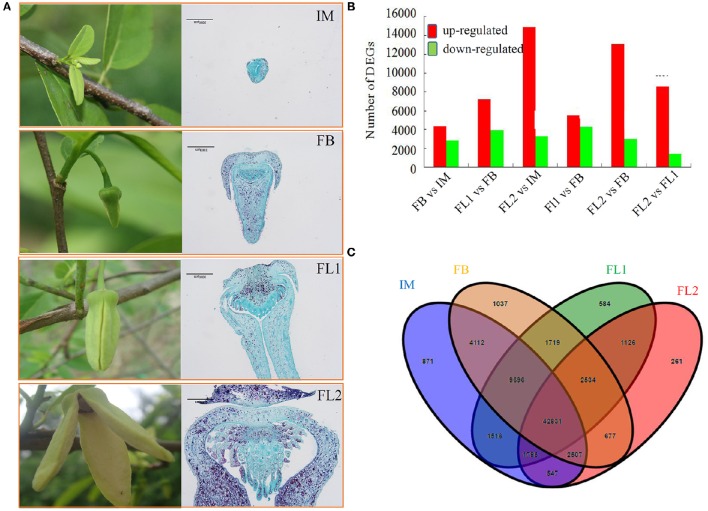
Analysis of the differentially expressed unigenes (DEGs) during the floral transition and flower development process in sugar apple. (A) Numbers of DEGs in different comparisons, including FB vs. IM, FL1 vs. FB, FL2 vs. IM, FL1 vs. FB, FL2 vs. FB, and FL2 vs. FL1. The red indicated up-regulated unigenes and green indicated down-regulated unigenes. (B) Venn diagram showed the number of DEGs in different stages of flower development. (C) The expression profiling of stage-preferential unigenes in sugar apple.